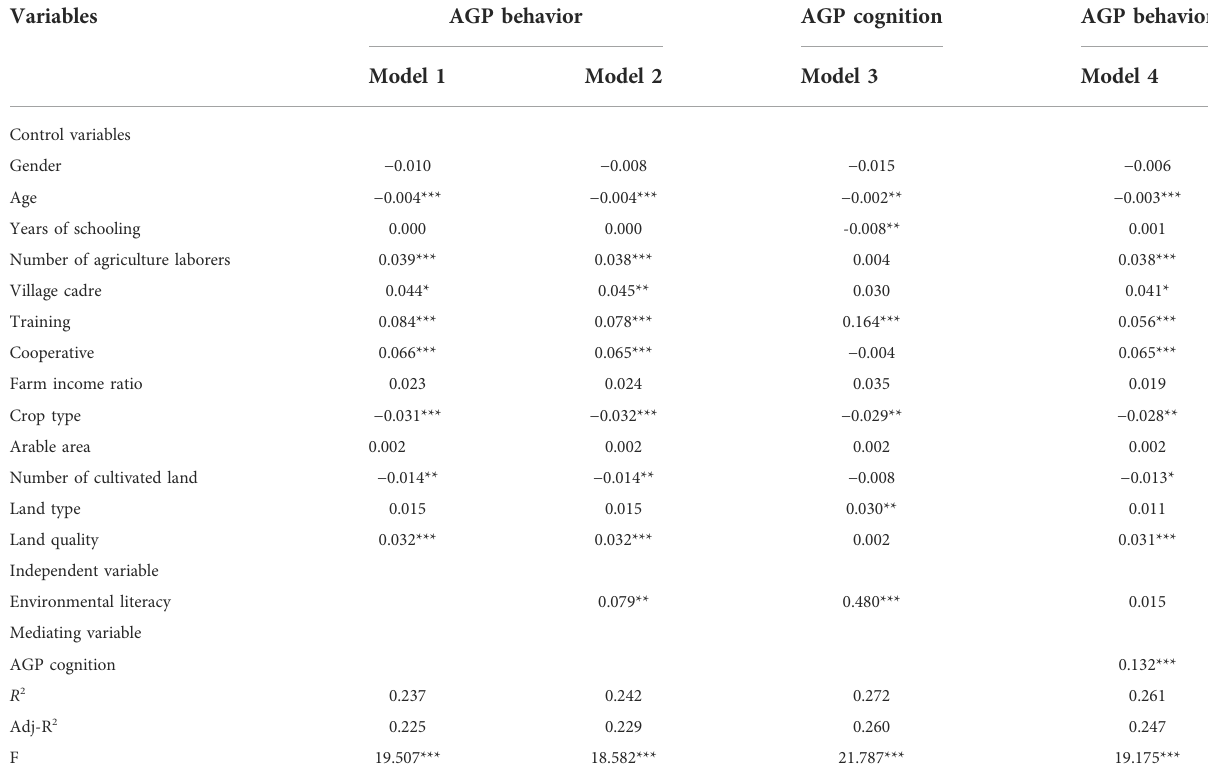
TABLE 7 The mediation effect of AGP cognition (Causal step regression).